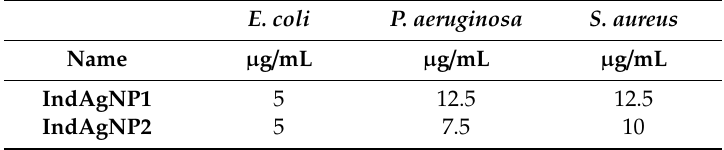
Table 6. Antibacterial activity of AgNPs conjugated to the peptide indolicidin against Gram-positive and negative bacteria. The antibacterial activity is expressed as MIC